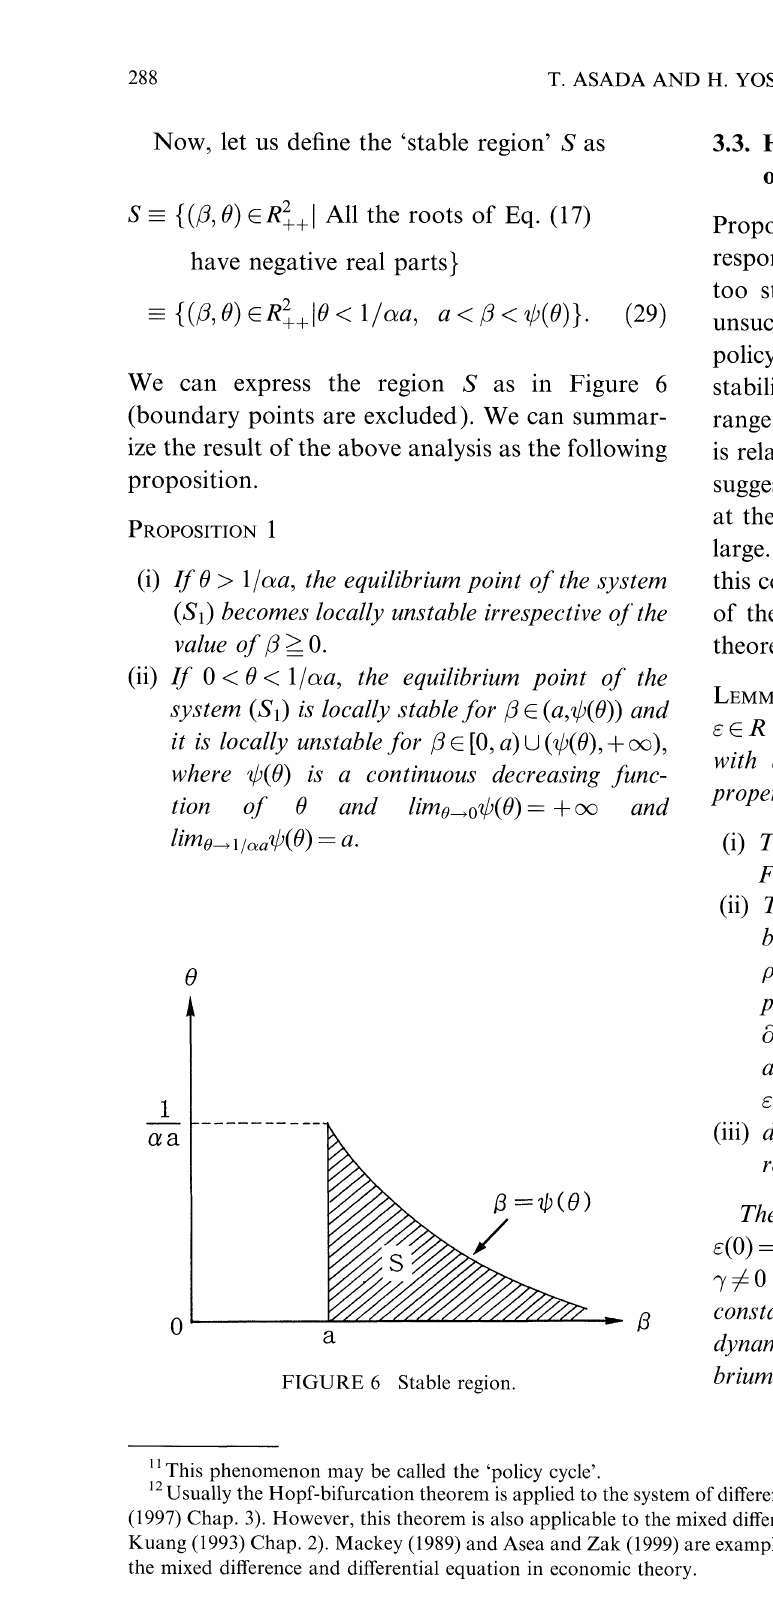
FIGURE 6 Stable